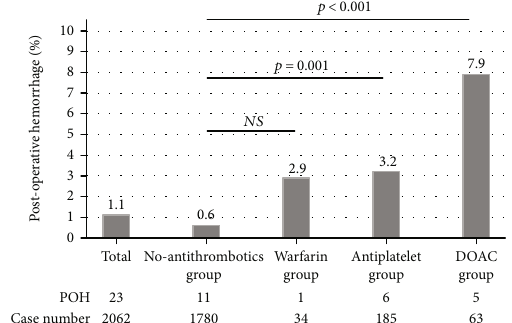
Figure 2: The rates of postoperative hemorrhage after endoscopic mucosal resection in the no antithrombotics, warfarin, antiplatelet, and DOAC groups.